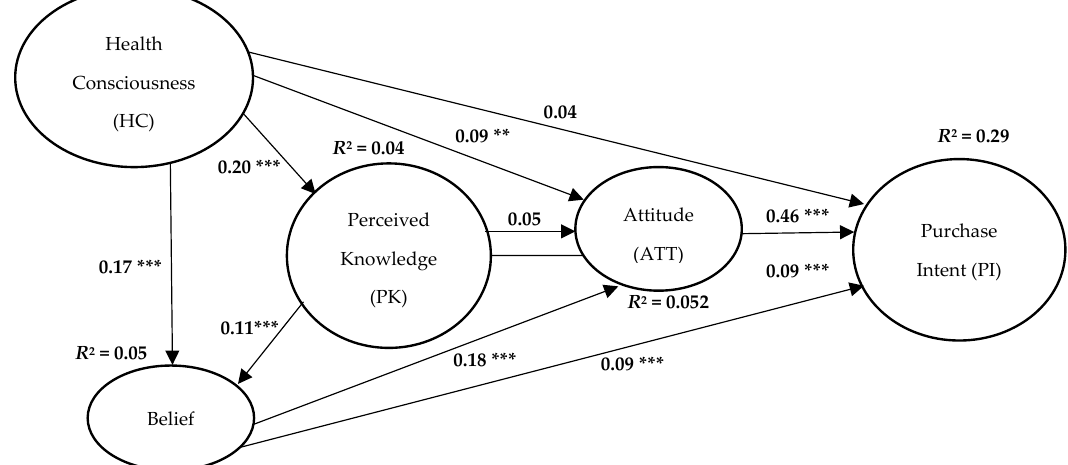
Figure 2. Results of hypotheses test on conceptual model. Note: *** significant at p < 0.01; ** significant at p < 0.05.